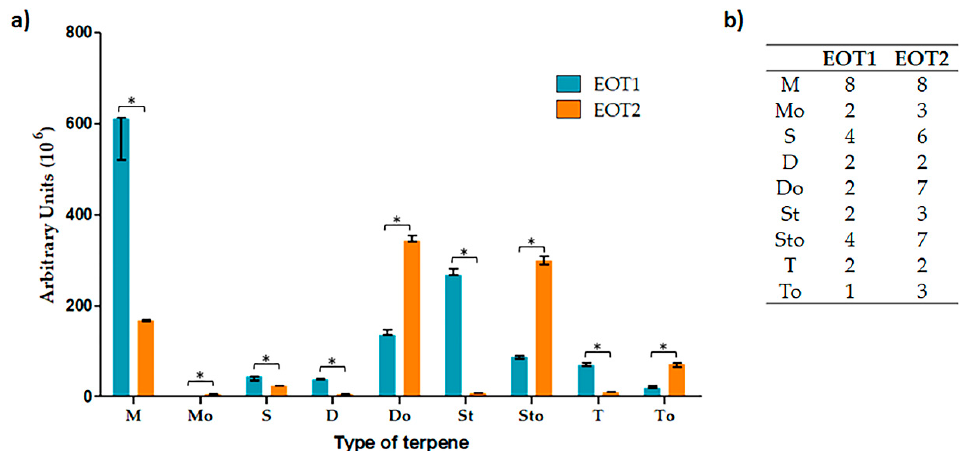
Figure 2. Analysis of the amount and type of terpenes. ( a ) The data are presented as the median of the peak area of each terpene (grouped by type) and the range of the data. M: monoterpene, Mo: monoterpenoids, S: sesquiterpene, D: diterpene, Do: diterpenoids, St: sesterterpenes, Sto: sesterterpenoids, T: triterpene, To: Triterpenoids. * Significant difference ( p ≤ 0.05). ( b ) Number of terpene compounds in each essential